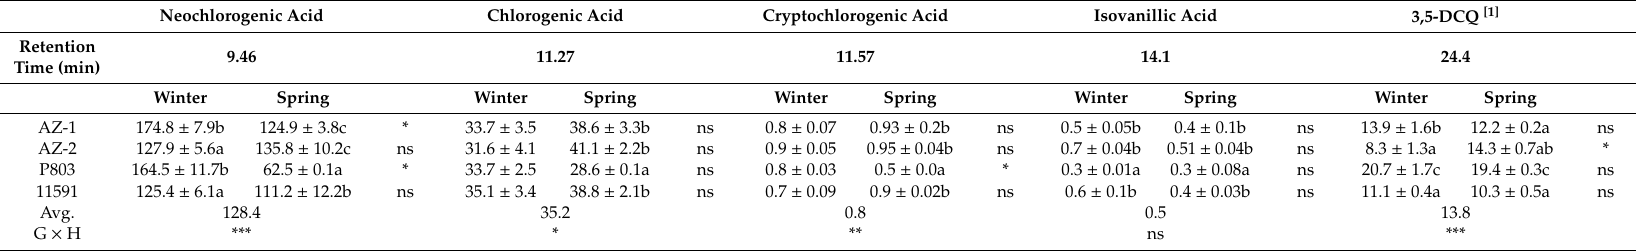
Table 4. HPLC analysis of phenolic acids (mg g − 1 DM) in leaves of the examined accessions of Parthenium argentatum harvested at 30 (winter) or 33 months (spring) after transplanting. (Means ± SD, n = 3, Fisher’s